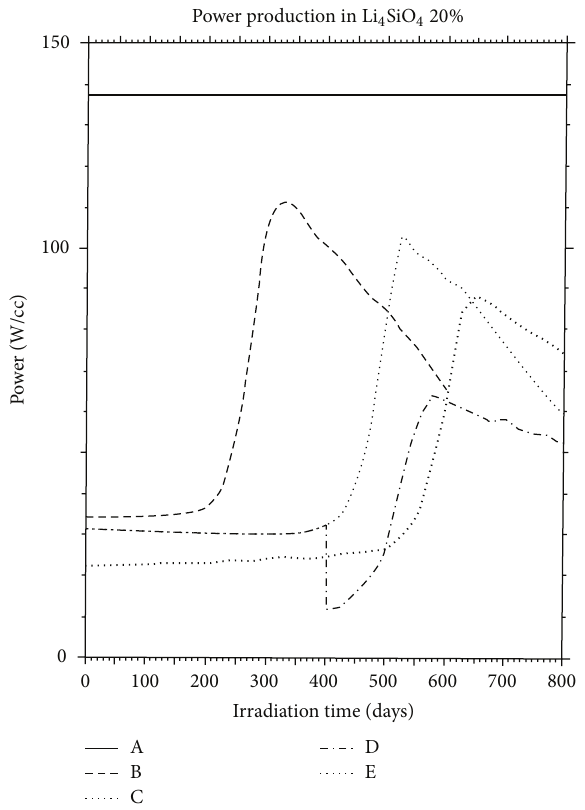
Figure 5: n- 𝛼 power production versus irradiation time calculated for Li 4 SiO 4 20% enriched in 6 Li. Notation for curves is as following: unshielded (A); 1mm Cd (B) and 2mm Cd (C); 2 mm Cd, 400 days at C7 and then at H8 (D); 2mm Cd and 0.5 mm Hf (E) [3].